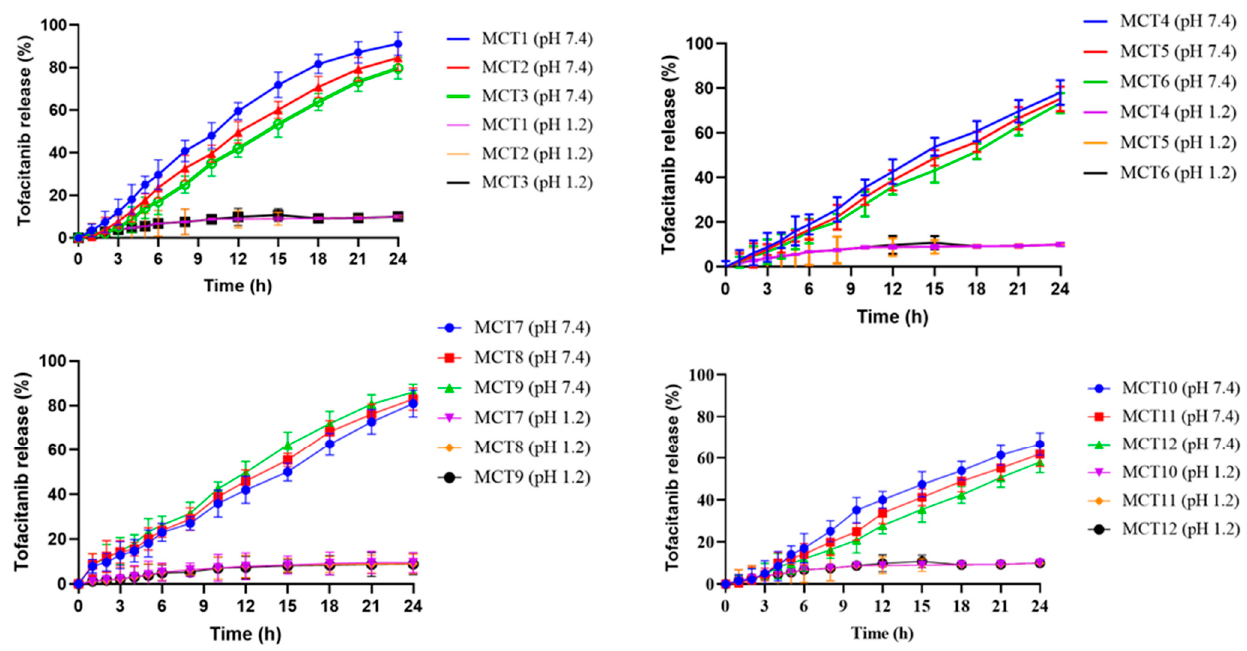
Figure 9. Results of tofacitinib release from developed formulations